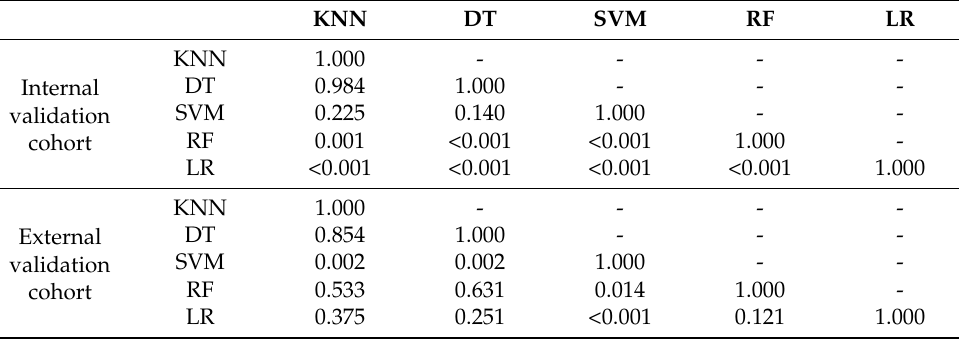
Table A1. The p -value for multiple comparisons for AUC of predictive models.